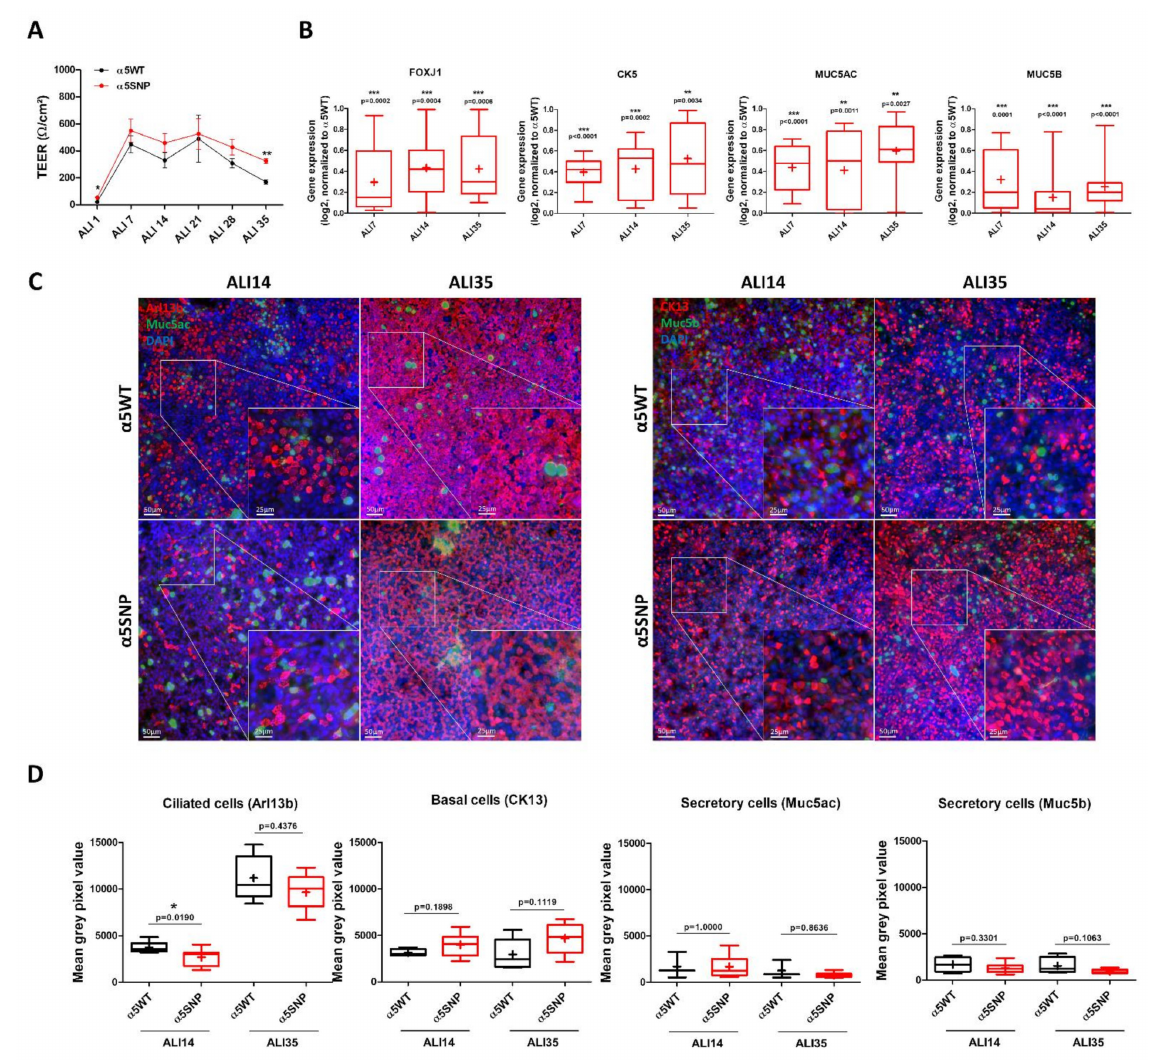
Figure 2. SNP rs16969968 alters respiratory airway epithelial cell differentiation. ( A ) Curves represent the TEER of AEC (n = 13) measured at ALI-1, ALI-7, ALI-14, ALI-21, ALI-28, and ALI-35 in α 5WT (black) and α 5SNP-expressing (red) cells. Means ± SEM are shown for each ALI time point. * p < 0.05; *** p < 0.001 α 5WT vs. α 5SNP. ( B ) Box and whisker plots (median with min to max, the plus sign (+) represents the mean value) represent the relative mRNA levels during ALI cultures by RT-qPCR ( n = 13) for differentiation markers (CK5, non-differentiated cells; FOXJ1, ciliated cells; MUC5AC/MUC5B, mucous-secreting cells) in α 5SNP-expressing groups. * p < 0.05; ** p < 0.01; *** p < 0.001 α 5WT vs. α 5SNP. ( C ) Examples of micrographs taken from AEC cultures at ALI-14 and ALI-35 showing multiciliated (Arl13b, red) and mucin-secreting (Muc5ac, green) cells on the left, basal (CK13, red) and mucin-secreting (Muc5b, green) cells on the right. Nuclei are stained in blue (DAPI). Magnification corresponding to the selected area is shown. ( D ) Box and whisker plots (median with min to max, the plus sign (+) represents the mean value) represent the mean grey pixel values of Arl13b-, CK13-, muc5ac- and muc5b-associated fluorescence at ALI-14 and ALI-35 in α 5WT (black) and α 5SNP-expressing cells (red) (n ≥ 3 for each group). * p < 0.05 α 5WT vs. α